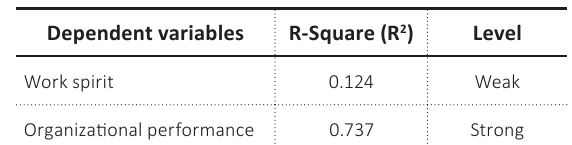
Table 4. R-Square (R 2 ) coefficient